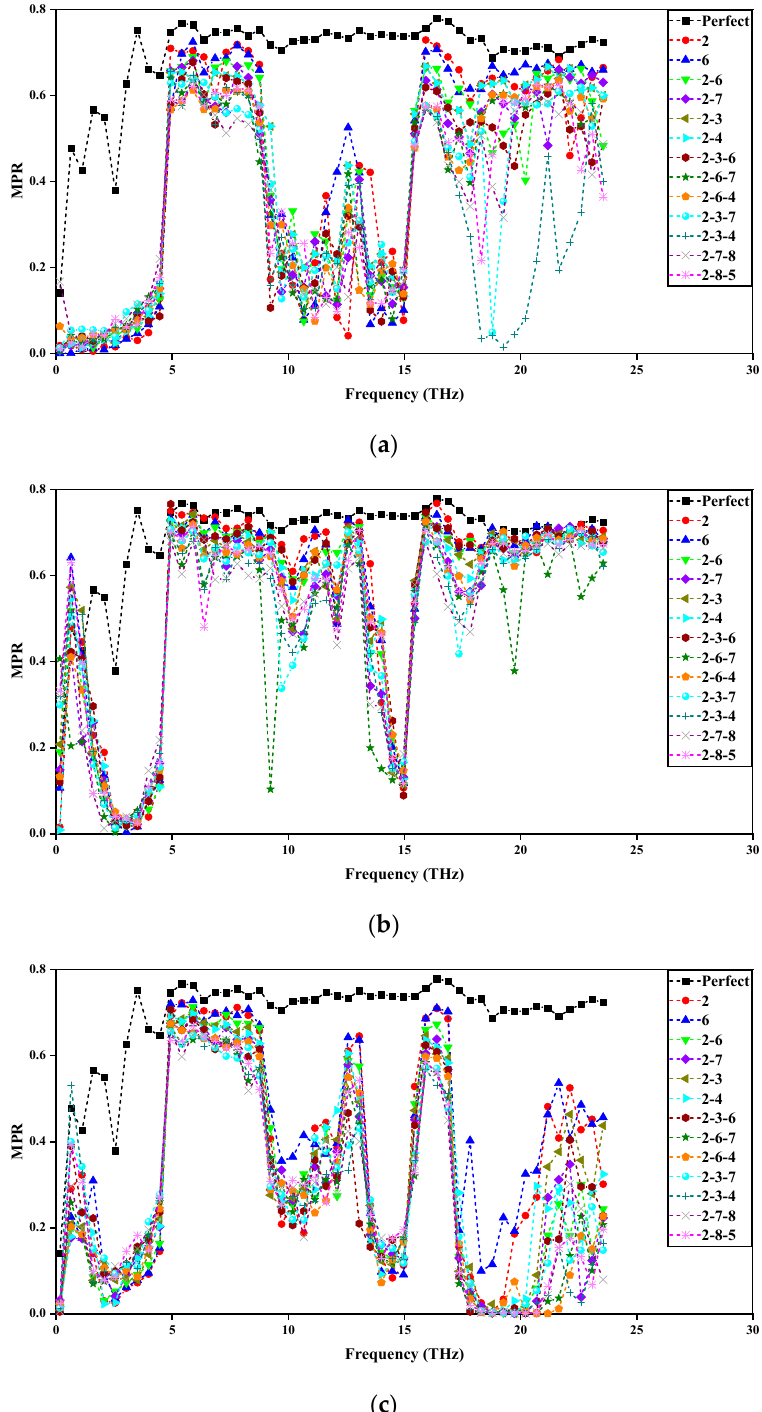
Figure 8. MPR: ( a ) concave; ( b ) perforation; ( c ) amorphous. The numbers represent small block labels. The calculation results are discrete frequency points. To better display the results, the frequency points are connected by dotted lines.